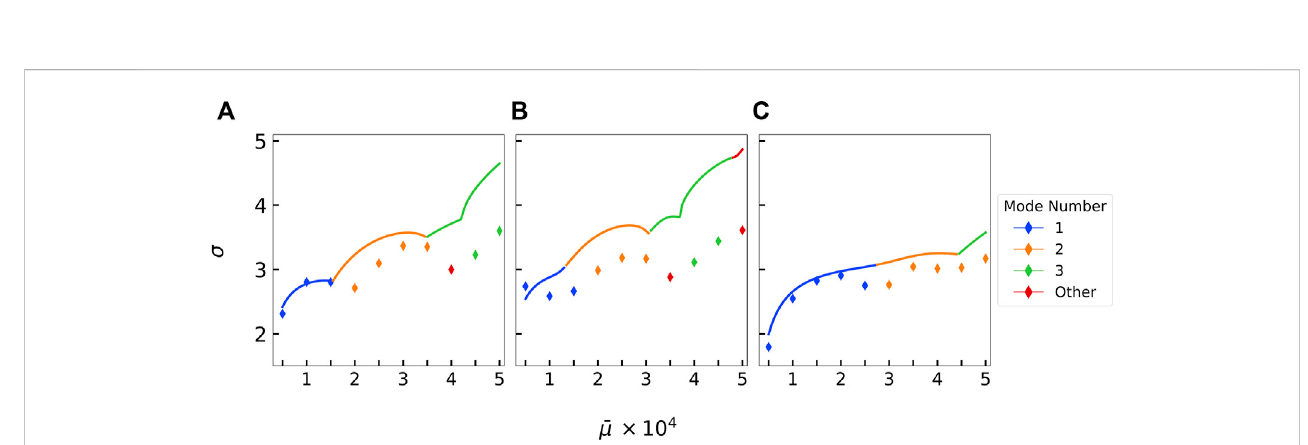
FIGURE 8 Comparison of the predicted growth rates obtained from linear stability analysis against the calculated growth rates from the Brownian extensional simulations at ℓ p / L =100 along with their corresponding mode number classi fi cationsfor (A) B 1 ( s ), (B) B 2 ( s ), and (C) B 3 ( s ). The highest growth rates from either stability analysis or simulations are plotted. Lines represent the stability analysis predictions. Diamond points represent the extracted growth rate from the